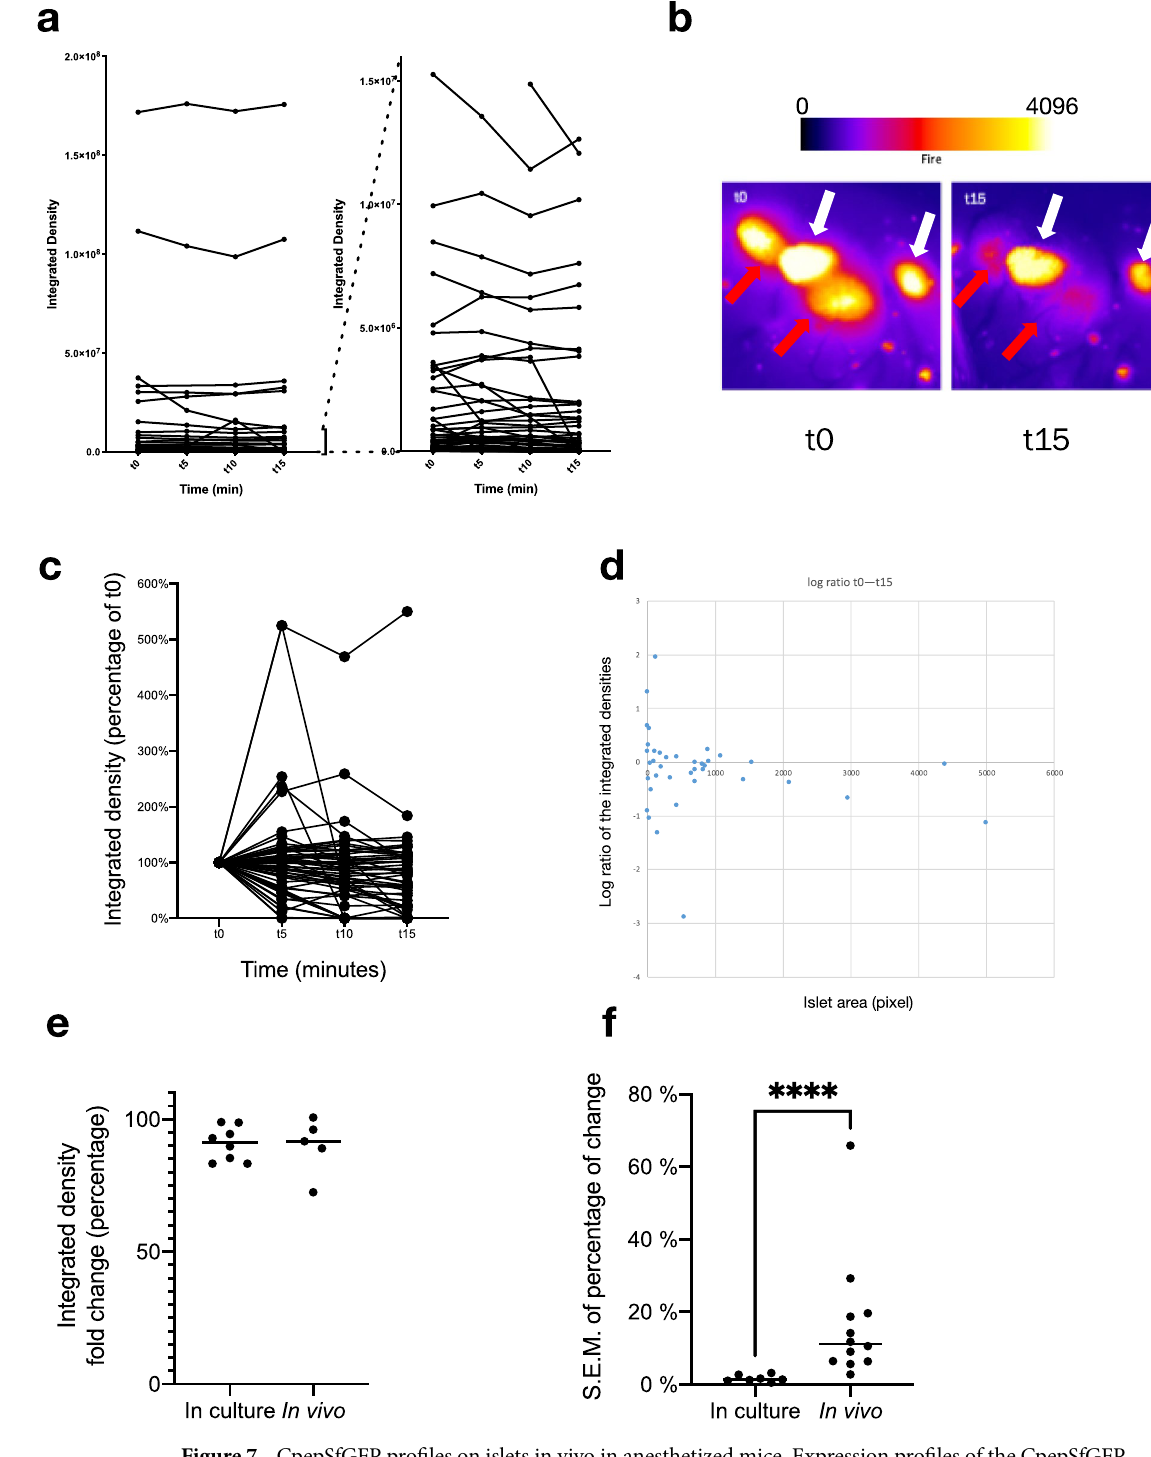
Figure 7. CpepSfGFP profiles on islets in vivo in anesthetized mice. Expression profiles of the CpepSfGFP islets in vivo in anesthetized mice after a glucose stimulation (gastric infusion) at t0. ( a ) Expression profile of all individual islets (left) or a subset of smaller islets (different scales on the right) over 15 min. ( b ) Pseudo-colored islets (fire lookup table, scale above) before stimulation (t0) and after 15 min (t15). The white arrows indicate islets that exhibit only modest changes in 15 min while the red arrows highlight adjacent islets that change dramatically over the same time course. ( c ) Integrated density of the individual islets expressed as a percentage at t15 relative to their value at t0. ( d ) Log ratio representation of the islet response based on the integrated density on the vertical axis and their area (expressed in pixels) on the horizontal axis. ( e ) Comparison of the total islet response to the glucose challenge in culture and in vivo (percentage change of the sum of all integrated densities in a culture well or a pancreas). ( f ) SEM of the islet response (comparing the distribution of individual islets response expressed as a percentage at t0 compared to t15) of islets in culture compared to islets imaged in vivo. ****p <